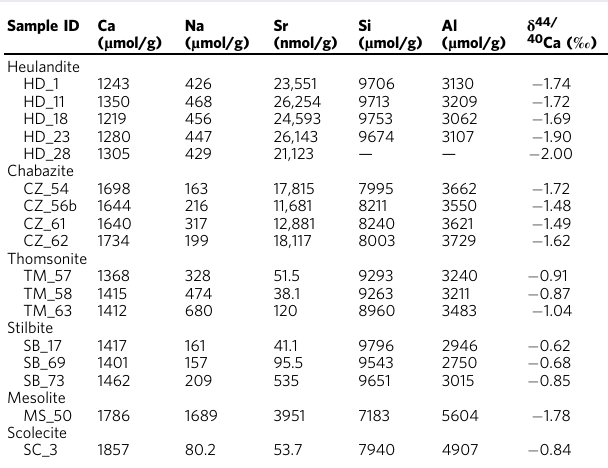
Table 2 Elemental and Ca isotope data for bulk zeolite minerals.